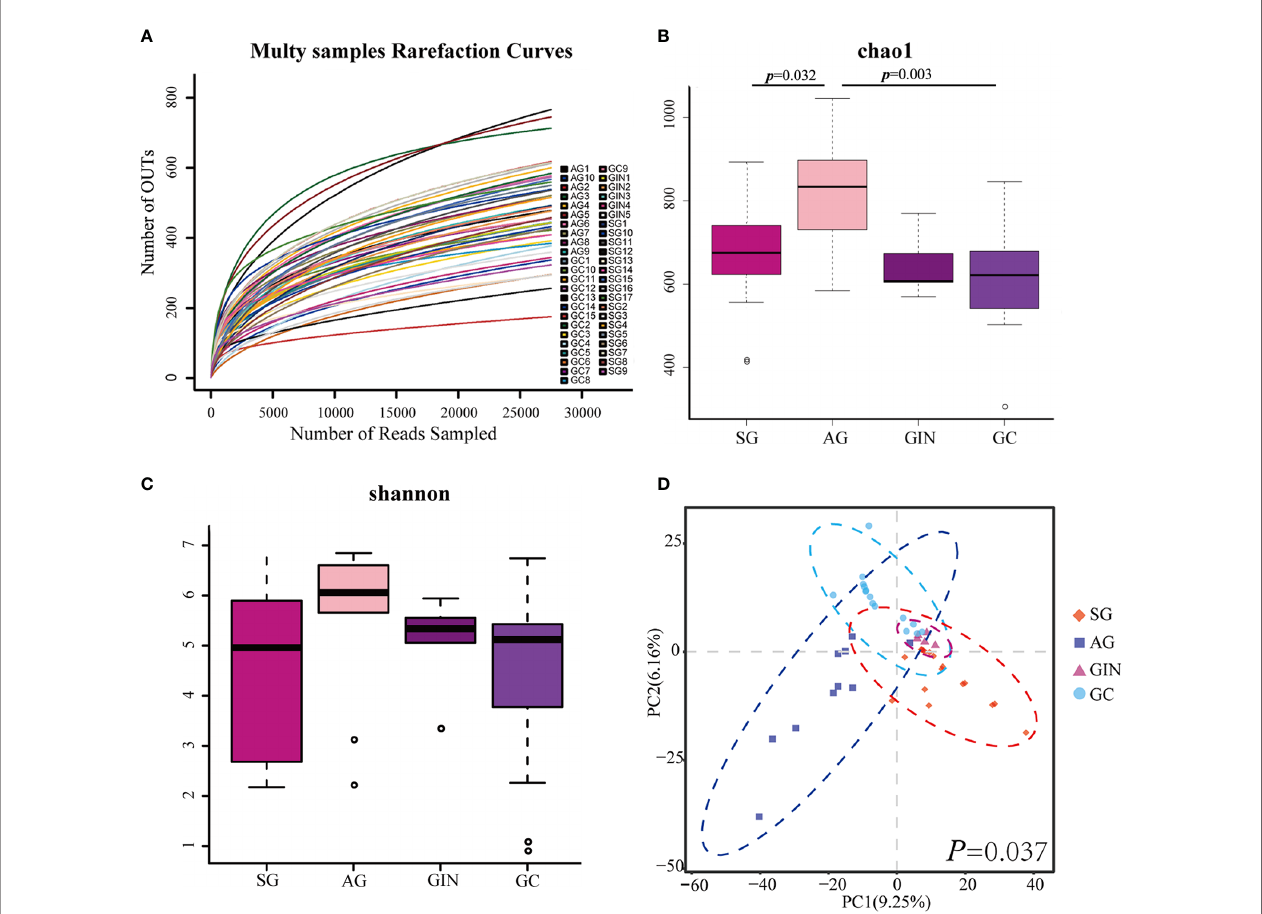
FIGURE 1 | The microbial a diversity and b diversity analysis in different groups. (A) Rarefaction curves for operational taxonomic units (OTUs). (B) Chao 1 index was higher in atrophic gastritis (AG) compared with super fi cial gastritis (SG) and gastric cancer (GC) and (C) there was no signi fi cant difference in Shannon index among the four groups (Student ’ s t-test was used to compare each two groups). (D) Partial least squares Discriminant Analysis revealed different microbial community structures in the four groups (ANOSIM was used to evaluate the similarity among